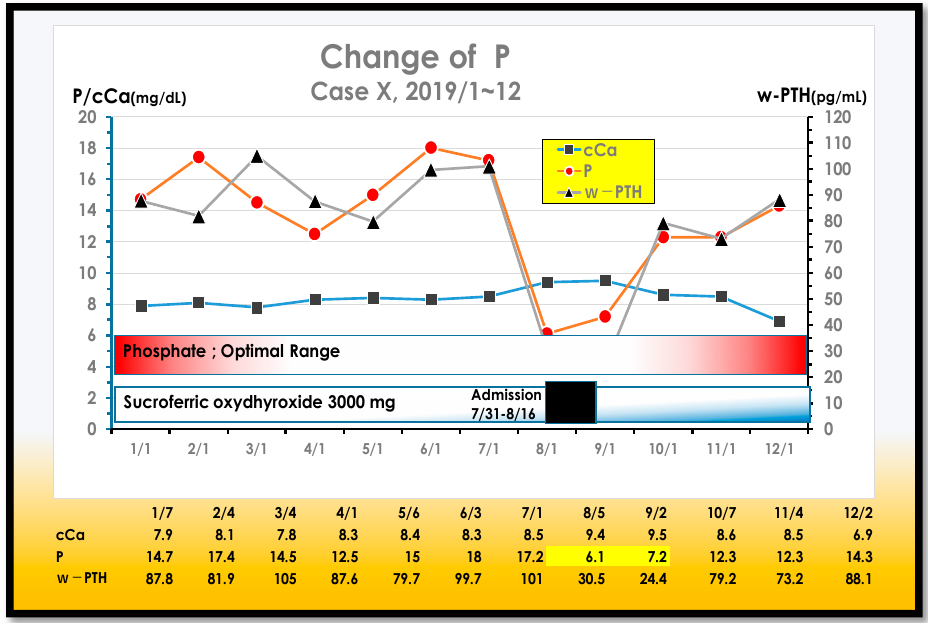
Figure 12. Annual P levels in a typical case of hyperphosphatemia. This case shows approximately 12 mg/dL of P throughout the year. However, after being hospitalized and placed on a P-restricted diet, the P dropped to almost the adequate range. Needless to say, the hyperphosphatemia was originated in the patient’s diet.